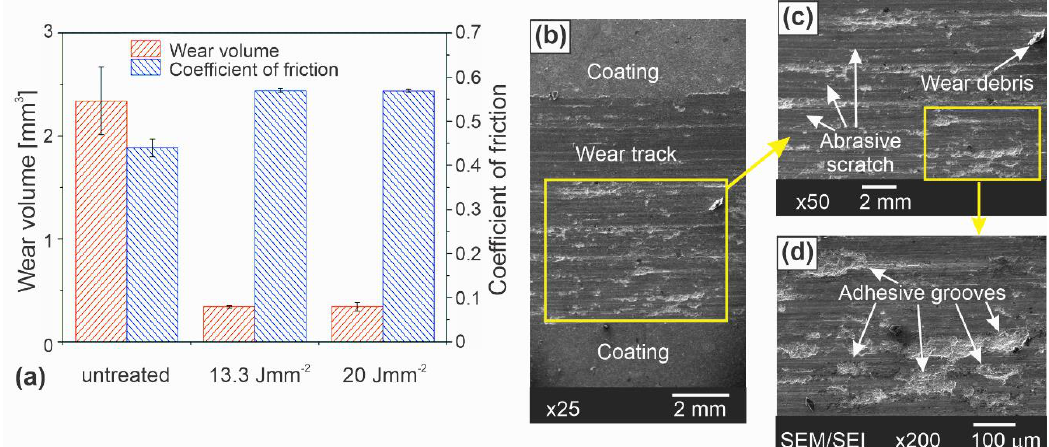
Figure 7. ( a ) Wear volume and coefficient of friction (COF) results of the substrate material and samples processed at different LEDs; ( b – d ) SEM/SEI images of wear scars of LSA coated sample processed with 20 J/mm 2 .